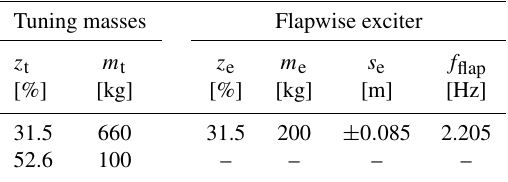
Table 1. Flapwise test setup with indication of location z t and mag- nitude m t of the tuning masses, location z e , mass magnitude m e and stroke s e of the exciter, and excitation frequency f flap